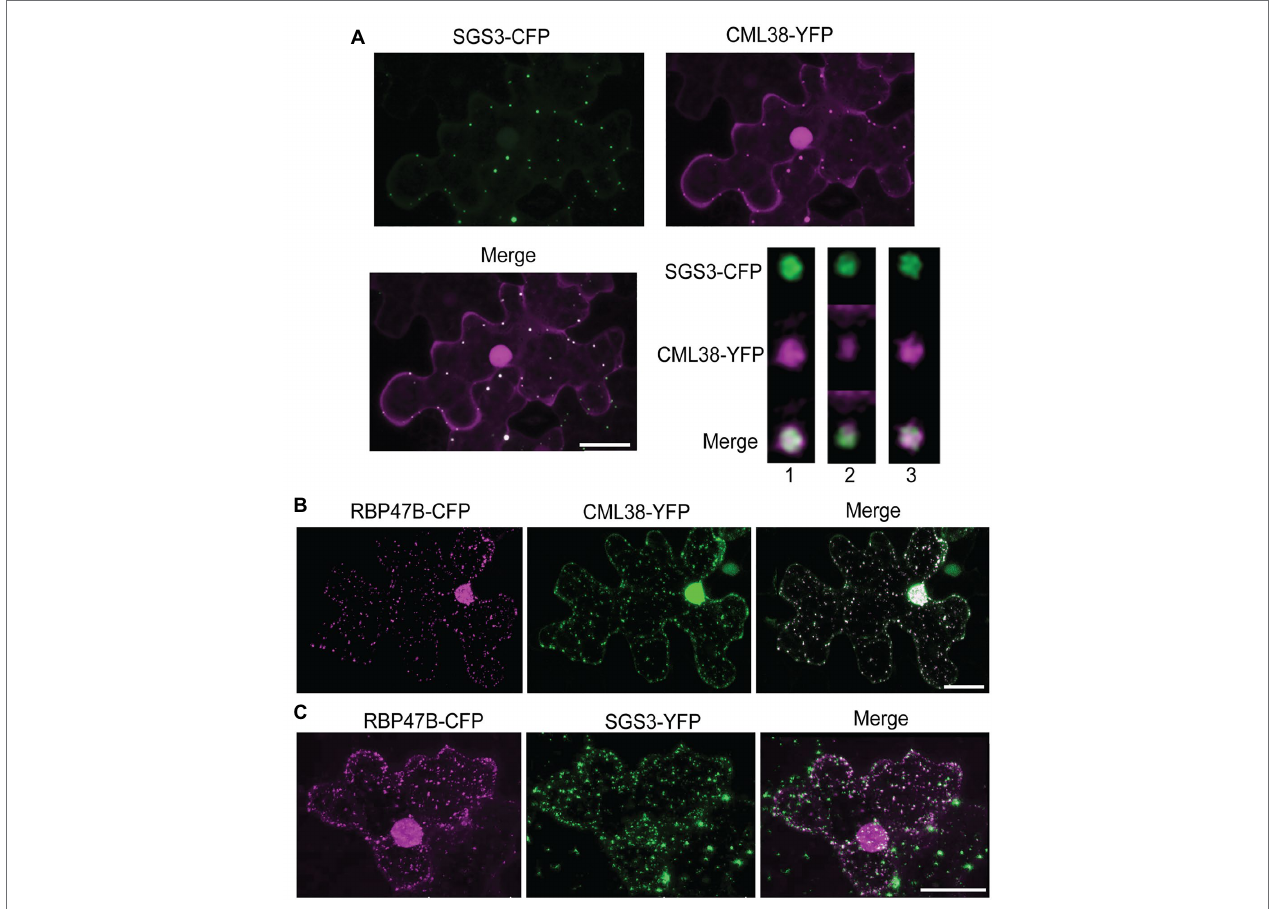
FIGURE 2 | CML38 co-localizes with SGS3 and RBP47B granules. (A) Co-localization experiment with Nicotiana benthamiana leaves co-transfected with constructs that express SGS3-CFP and CML38-YFP. Leaf sections were subjected to submergence-induced hypoxia (3 h) prior to imaging. The image is a 2D projection of 25 optical sections (0.8 μ m/section) and subjected to standard deconvolution as described in the Materials and Methods. The panel at the bottom right represents analysis of a single SGS3/CML38 granule showing three successive 0.23 μ m optical sections with Lightning deconvolution demonstrating co-localization of the two signals. (B) Co-localization experiment with N. benthamiana leaves co-transfected with constructs that express CML38-YFP and the stress granule marker RBP47B-CFP followed by submergence-induced hypoxia (1 h) prior to imaging. The image is from 18 optical sections (2 μ m/section). (C) Co-localization experiment with N. benthamiana leaves co-transfected with SGS3-YFP and RBP47B-CFP. Leaf sections were subjected to submergence-induced hypoxia prior to confocal microscopy imaging. Scale bars are 25 μ